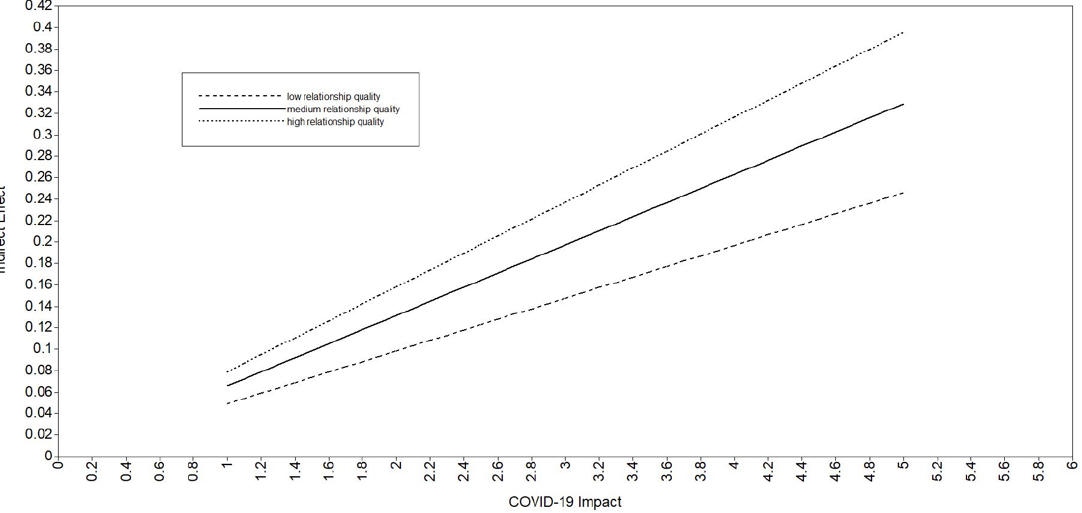
Figure 2. Plot of the Indirect Effect of COVID-19 Impact on Anxiety Symptoms Through Financial Distress at Different Levels of Romantic Relationship Quality (Model 2). Note: low = one standard deviation below the mean, medium = the mean, high = the highest value.